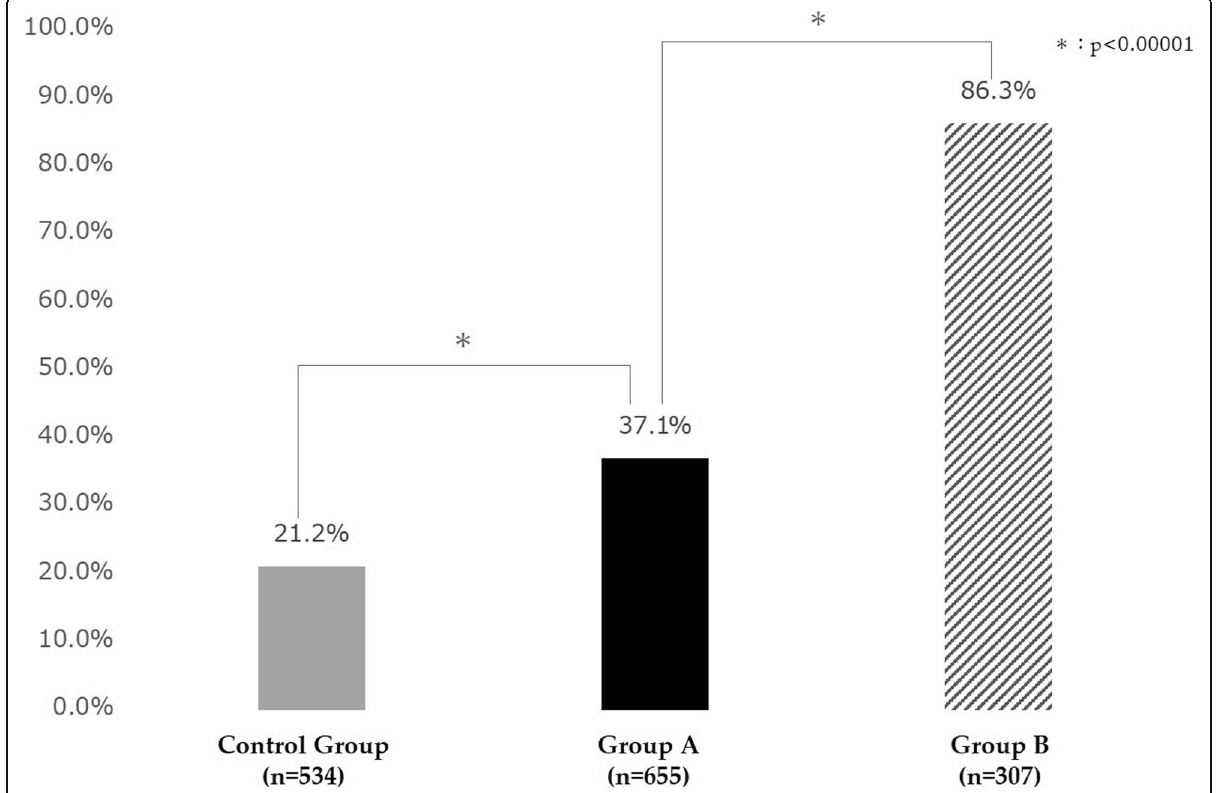
Fig. 4 The effectiveness of each client reminder. This figure compares the hepatitis screening rate in the control group in gray ( n = 534, default design for reminder, screening at usual cost), group A in black ( n = 655, nudge theory applied to reminder, screening at usual cost), and group B which is shaded ( n = 307, nudge theory applied to reminder, screening fully subsidized). The screening rate for group A was 15.9% higher than the control group ( p < 0.00001), and the screening rate for group B was 49.2% higher than group A ( p < 0.00001). The comparisons were done